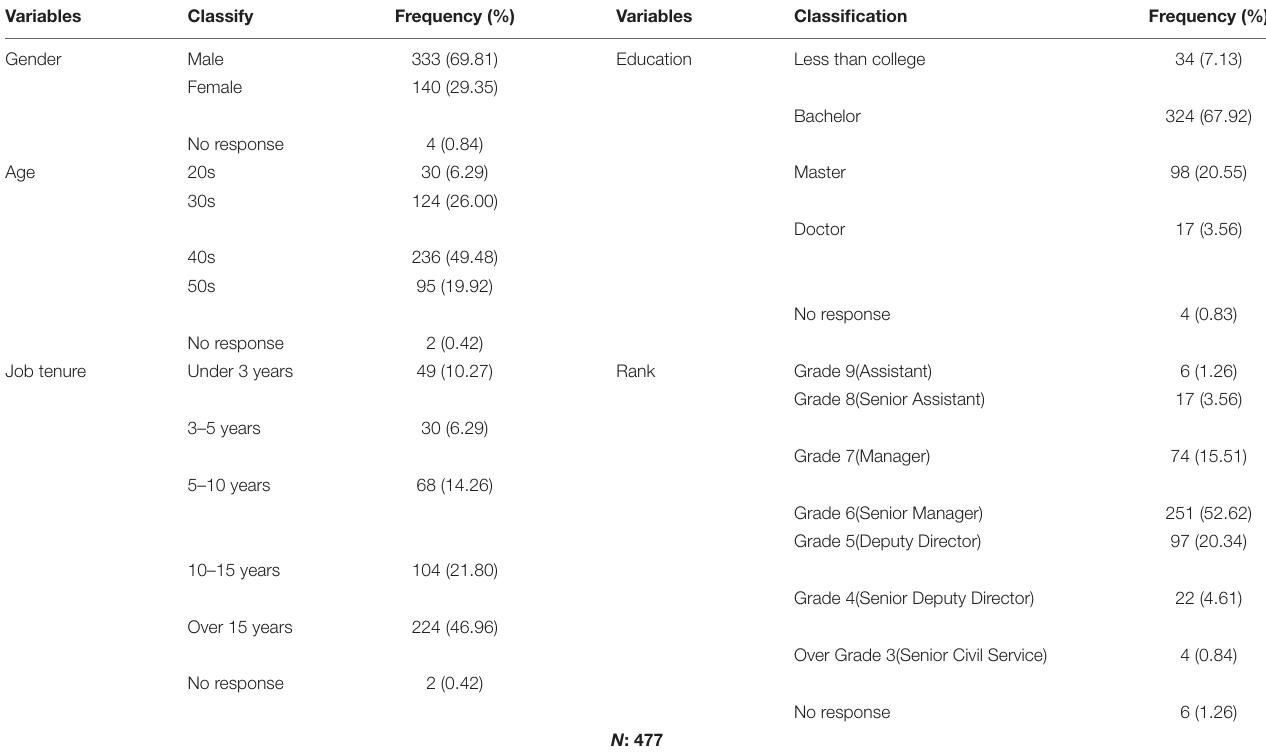
TABLE 3 | Characteristics of the survey